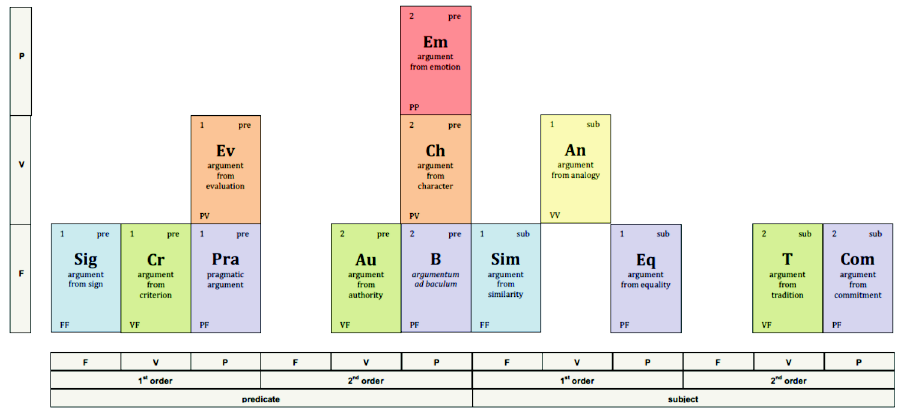
Figure 2. The Periodic Table of Arguments as depicted in Wagemans (2016: